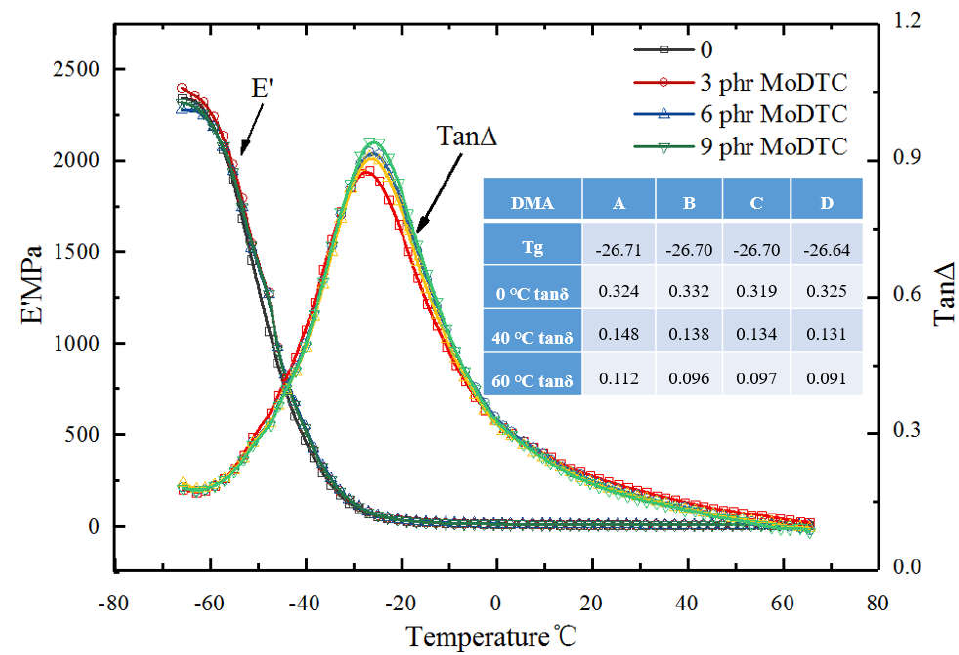
Figure 8. The E’ and TanΔ of the DMA test.